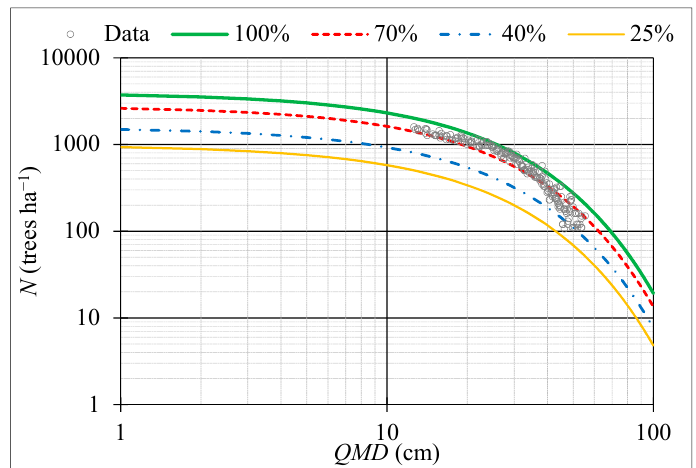
Figure 3. Density management graphic (DMG) with variable initial density and instantaneous common